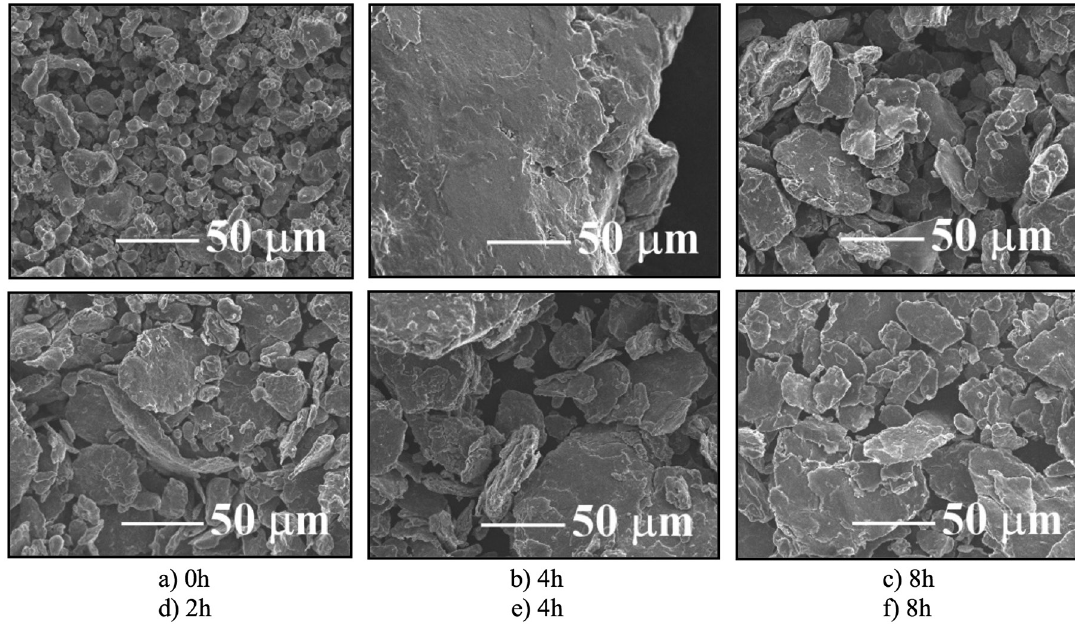
Figure 1. SEM-SE micrographs of sample powders: Al and Al-0.5%MG composite at different milling times: a) 0h, b-e) 4h, c-f) 8h and d) 2h.